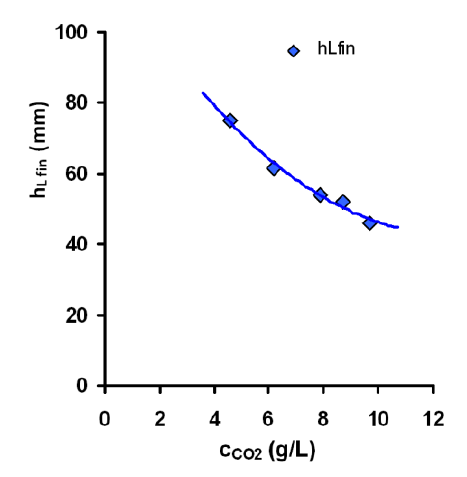
Fig. 14. Liquid formation – effect of CO 2 content: parameter h L fin